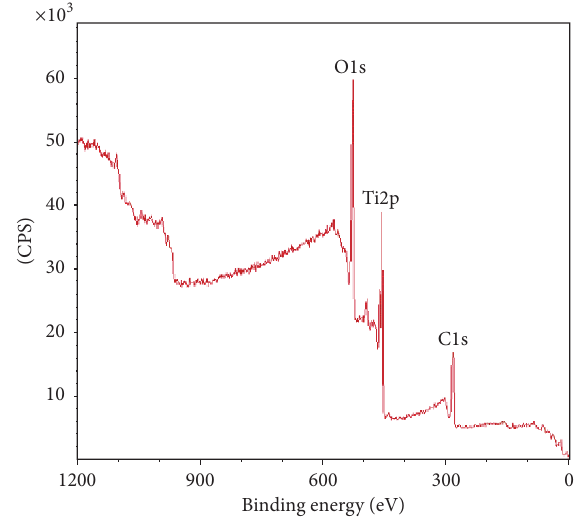
Figure 4: X-ray spectra of CN G /TiO 2 .